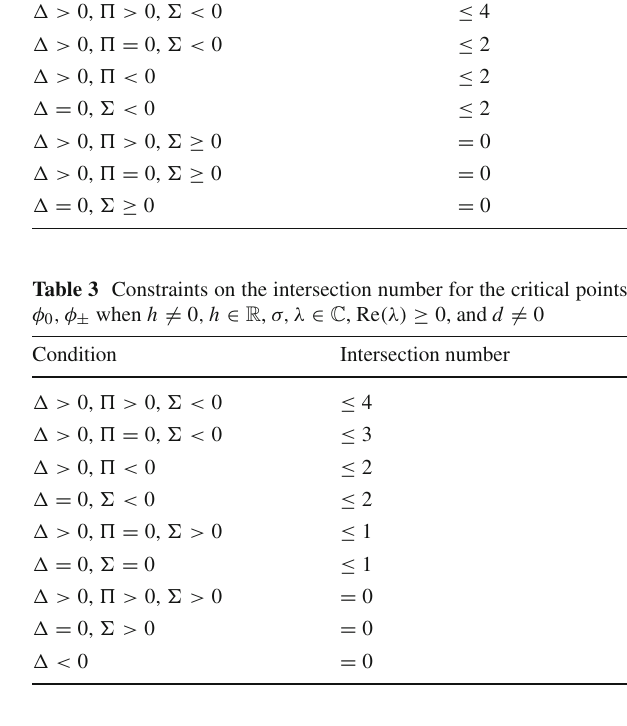
Table 2 Constraints on the intersection number for the critical points φ ± when h = 0, σ,λ ∈ C , Re (λ) ≥ 0, and d (cid:10)= 0 Condition